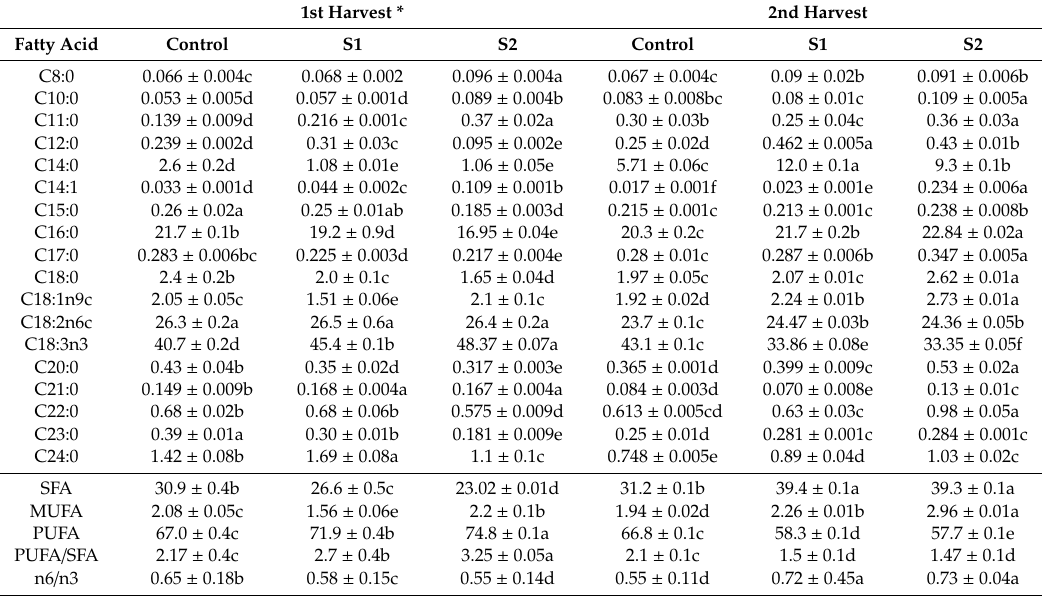
Table 6. Fatty acids composition (relative %) of Centaurea raphanina subsp. mixta leaves in relation to harvesting time and salinity level (mean ± SD, n =